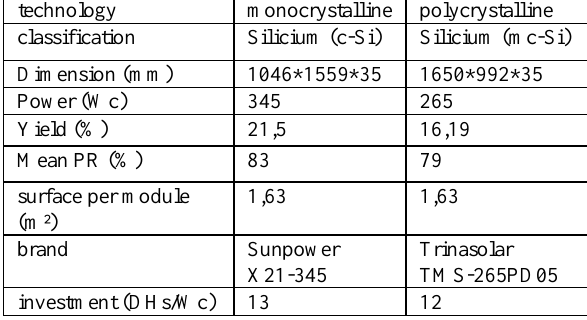
Table. 1: PV technologies and features The Pr is defined as the ratio of on-field performance of the system to its performance in standard test condition of 1000 W/m2 global insolation, 25°C module temperature and